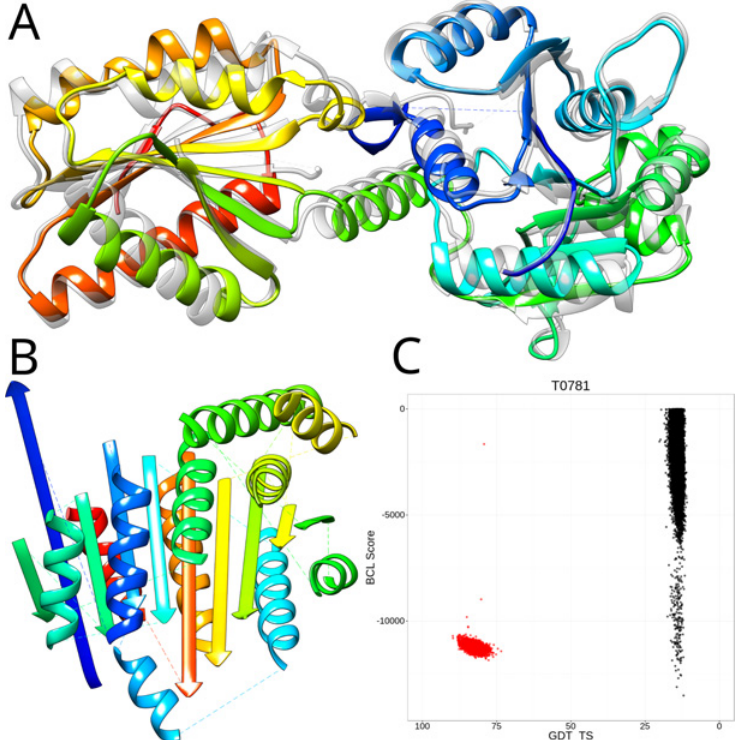
Fig 6. Limitations in the conformational sampling hinder structure prediction for regular target T0781. (A) Experimentally determined structure of T0781 (PDB entry 4QAN, grey) superimposed with the same structure after relaxation with the BCL scoring function (rainbow). (B) Best scoring de novo model predicted by BCL::Fold. (C) Shown are the BCL score of the models (y-axis) and the GDT_TS of the model relative to the experimentally determined structure (x-axis). Relaxing the experimentally determined structures in the BCL::Fold scoring function reveals native-like conformations with a favorable score (red dots). In comparison, the de novo folded conformations observed during the CASP experiment (black dots) achieve comparable scores but don ’ t include conformations, which are structurally similar to the experimentally determined